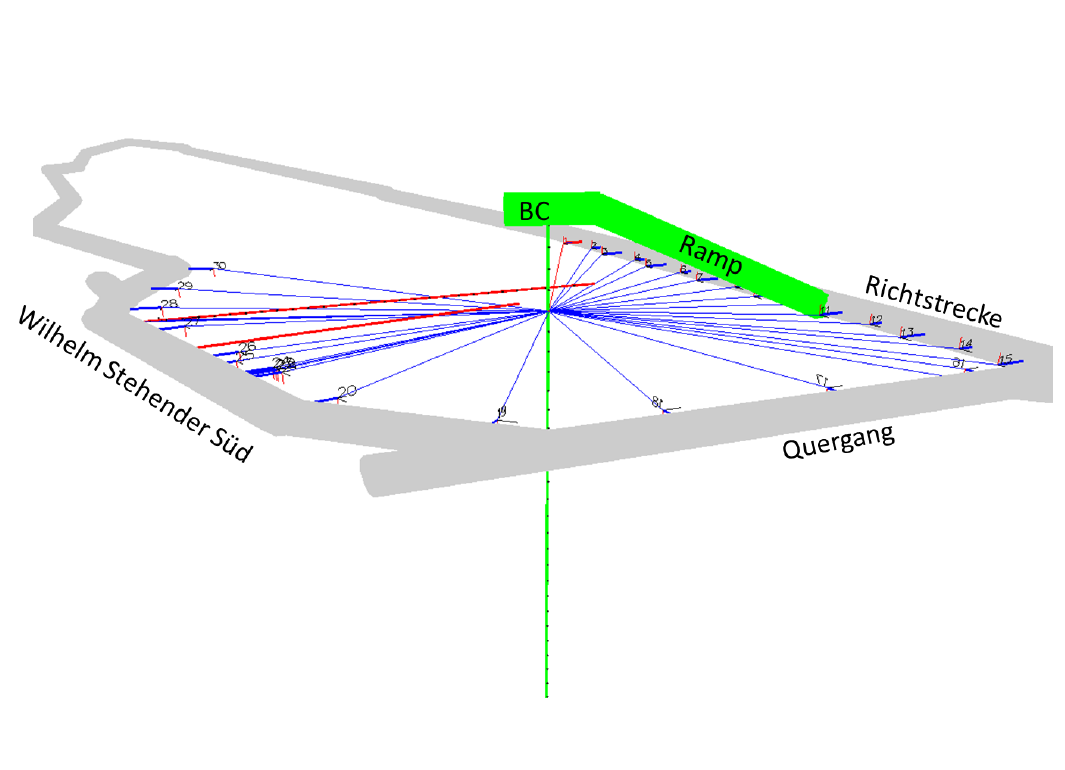
Figure 1: Perspective view of the GFZ Underground Laboratory. The horizontal boreholes BH1 and BH2 are 30 m and 20 m long (red lines). A 70 m deep vertical borehole BH3 (blue) is located in the center and accessible via a ramp (Ramp) and a chamber (BC). Thin blue lines mark the rays between a borehole source point at 10 m depth and the thirty 3-component